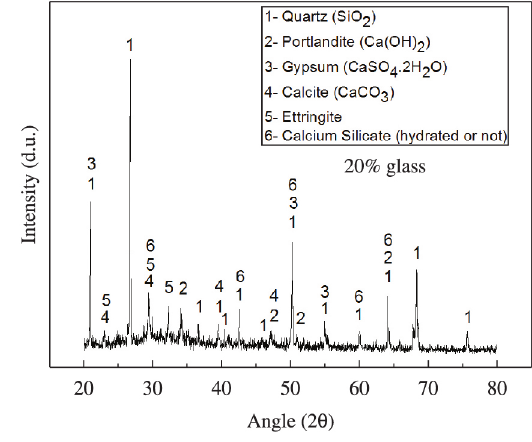
Figure 10. XRD diffractogram of concrete with 20% glass content and a w/c ratio of 0.50.